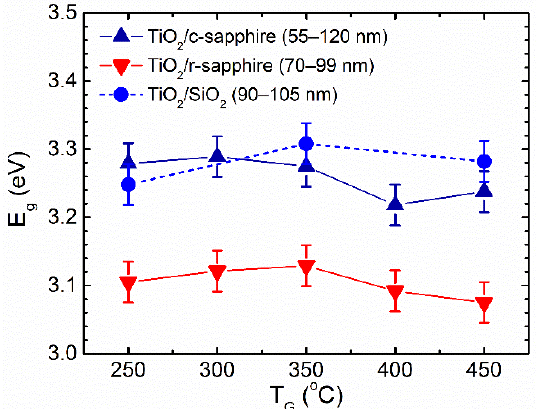
Figure 12. Optical bandgap values for TiO 2 films grown at different temperatures on c- and r-sapphire, and on SiO 2 substrates. Mean values for films with the thicknesses shown in the figure are presented.